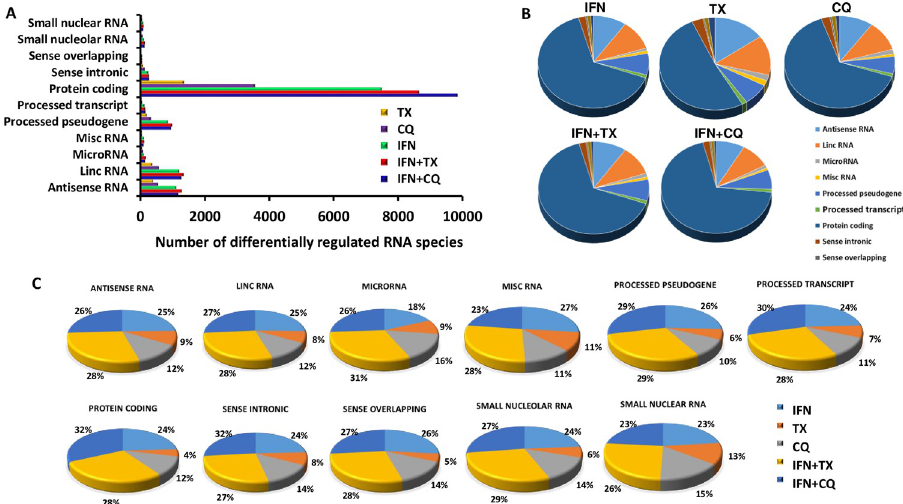
Fig 2. Quantification of differentially regulated ncRNAs using RNA sequencing data. A. Absolute numbers of differentially regulated ncRNAs per treatment; B. Pie charts indicating the percentages of various ncRNAs whose expression changes due to treatments; C. Pie charts indicating changes in percentages of indicated ncRNA types due to treatments.